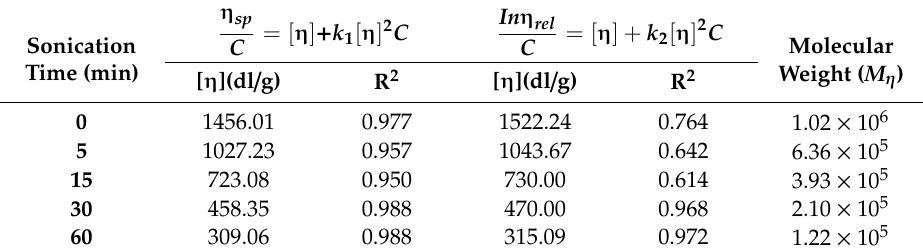
Table 1. E ff ect of sonication time on intrinsic viscosity and molecular weight of KGM